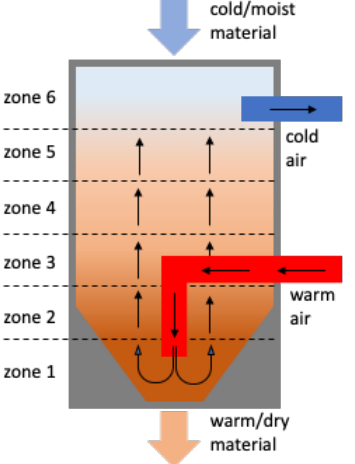
Figure 2. Schematic view of a drying hopper with temperature probe.